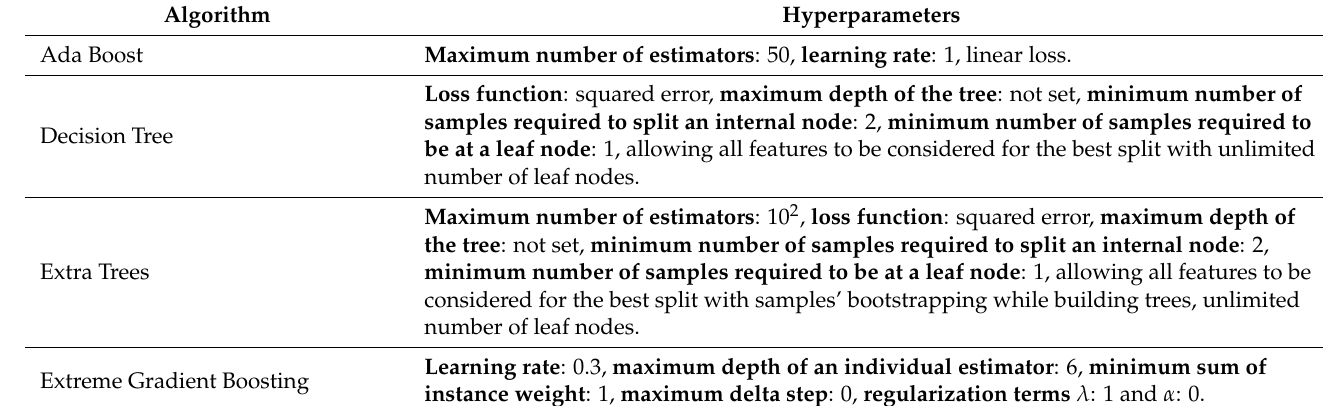
Table 4. The most important hyperparameter values, as suggested by Pedregosa et al. [56], of all parameterized machine learning algorithms investigated in this